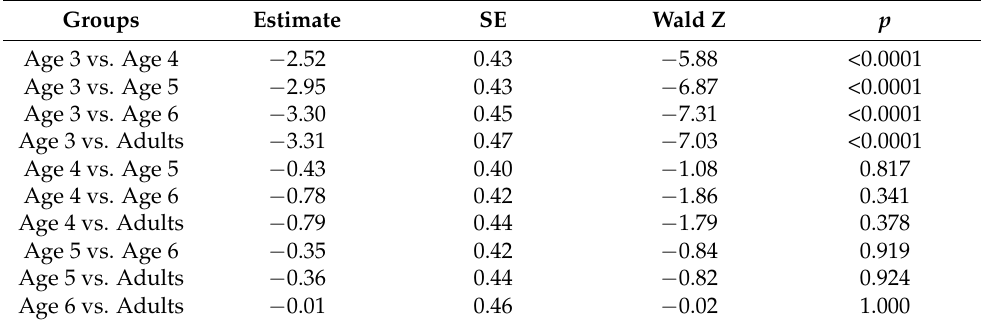
Table 5. Summary of the age factor in the mixed effects logistic regression model for producing FULL RC S